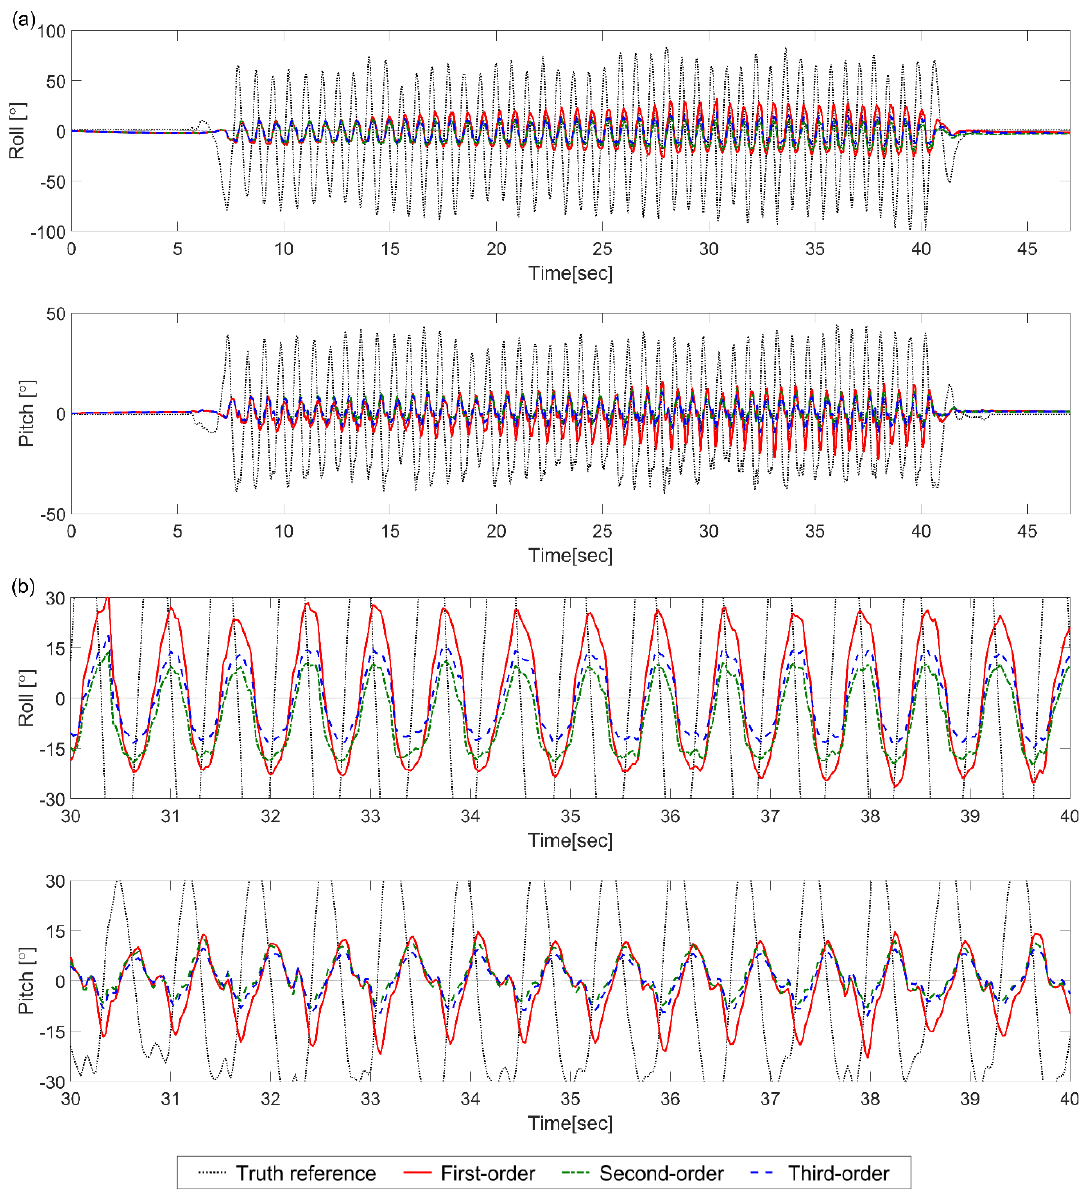
Figure 2. Results of Test C (40 Hz) for Case 1: ( a ) roll and pitch estimation errors from the first-order KF (red solid), the second-order KF (green dot-dash), and the third-order KF (blue dashed) with respect to the truth reference angle (black dotted); ( b ) enlarged subsections for 10 s.